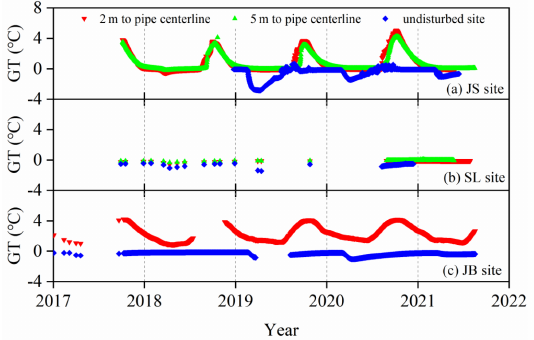
Figure 7. Variations in ground temperatures (GTs) at the depth of 3m on the right-of-way (ROW) at the (a) JS, (b) SL and (c) JB